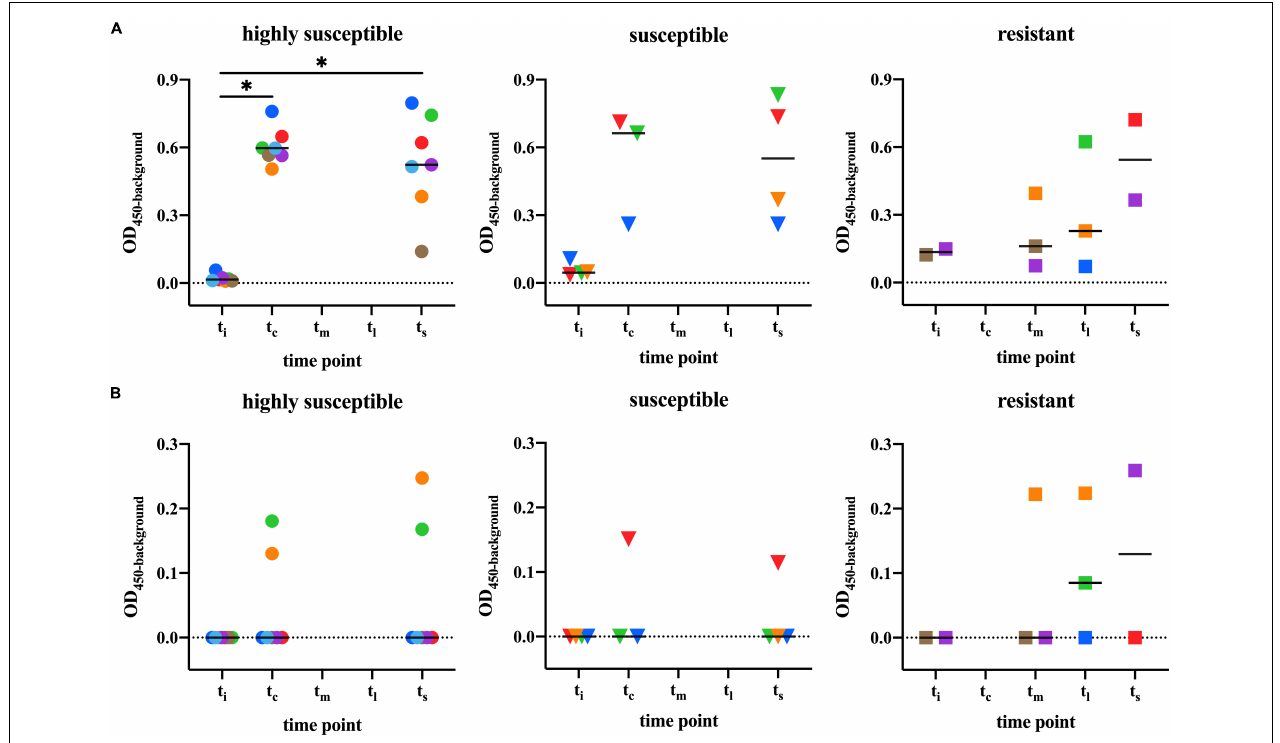
FIGURE 2 | Anti-PGL-I antibody levels in M. leprae infected armadillos. Anti-PGL-I antibody levels were measured by ELISA in serum from M. leprae [1 × 10 9 bacilli; NHDP 63 ( n = 9), NHDP 98 ( n = 4), or Brazil 4923 ( n = 4)] infected armadillos. Sample derived from each animal is represented by the same symbol. After infection, seven armadillos disseminated before 12 months (highly susceptible; dots), four disseminated and progressed to disease within 24 months (susceptible; triangles), and six armadillos did not disseminate even 36 months post-infection (resistant; squares). ELISA results of anti-PGL-I IgM (A) and anti-PGL-I IgG (B) are displayed as optical density at 450 nm corrected for background OD values (OD 450 - background ; y-axis ). The median values per group are indicated by horizontal lines. Differences between pre-infection (t i ) vs. post-infection (t c /t m /t l /t s ) were determined by Wilcoxon matched-pairs test. P -values: ∗ p < 0.05. t i , time of inoculation; t c , time of seroconversion (for highly susceptible and susceptible animals); t m , mid-stage disease; t l , late-stage disease; t s , time at